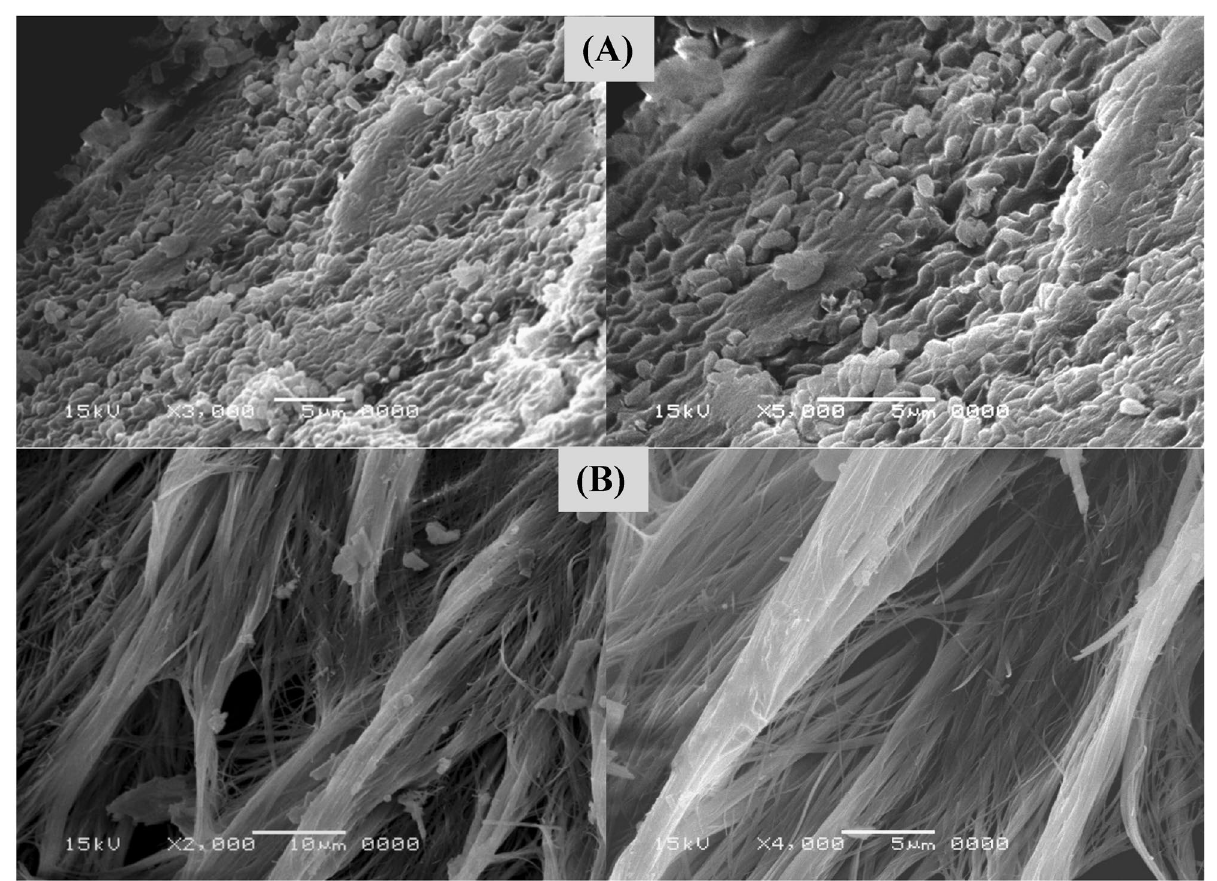
Figure 6. (A ) SEM electron micrograph for Bacillus tequilensis strain SEE-12 trapped in bacterial cellulose network; ( B ) scanning electron microscopy morphology of BNC (Fig. 7A) show needle-shaped particles with diameters of 8.54 ‒ 24.91 nm and lengths of 65.36 ‒ 217.3 nm. Some nanoparticles were agglomerated into bundles. Generally, agglomeration occurs as a result of Van der Waals forces amongst nanoparticles 97 . ImageJ/Fiji Software, Version 1.48 was used for measuring the size of BNC parti- cles obtained from TEM images. In order to provide an adequate statistical analysis, the length (major axis), and the width (minor axis) were measured. Minitab Statistical Software (Version 19) was used for statistical analysis of the measurement results. The histograms of length and width distributions for BNC particles were plotted and shown in Fig. 7B. The means of the particles width and length were 16.64 and 131.1 nm, respectively. Energy dispersive x‑ray diffraction (EDX). Materials’ characteristics are always proportional to their molecular structure and composition. The selected micrographs of the surface of bacterial cellulose samples were investigated by use Energy dispersive x-ray diffraction (EDX) attached with FESEM to reveal its elemental composition 38 . In this study, The EDX spectrum (Supplementary Figure S4) shows the nanocellulose possesses carbon and oxygen with percentages of 48.56% and 51.44% respectively.